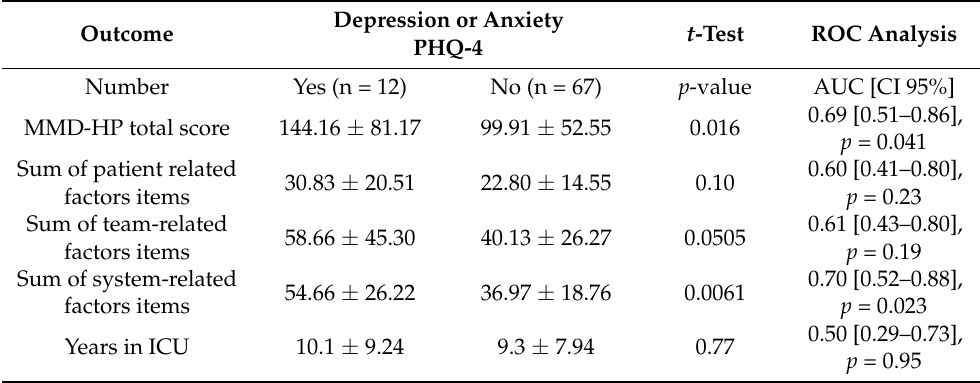
Table 4. Mean values for MMD-HP score and subscales, as well as experience of ICU work in nurses presenting with depression or anxiety symptoms on the PHQ-4 score.